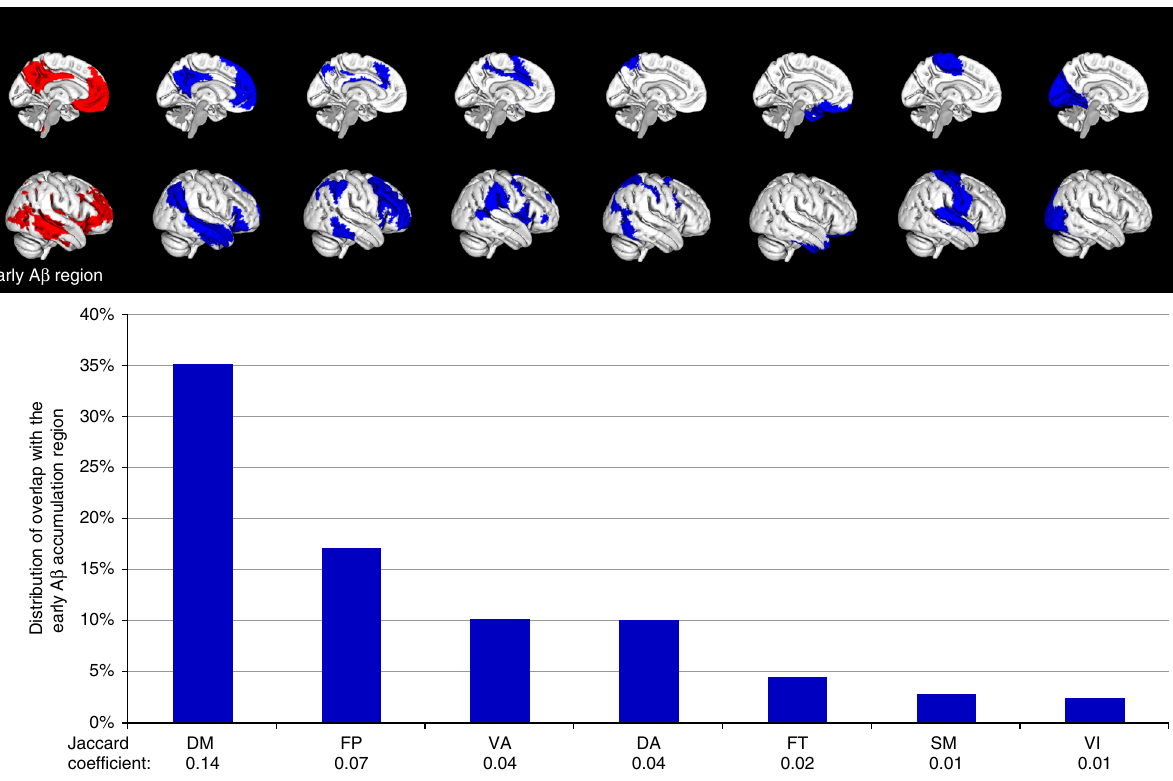
Fig. 2 Distribution of early A β accumulation among functional networks in ADNI. The bars show the distribution of the overlap between the signi fi cant cluster of early A β accumulation (shown in red, see also Fig. 1a) and the functional network ROIs (shown in blue above the bars). The sum of the seven bars is therefore 100%. The pattern of early stage A β fi brils overlapped mostly with the DM followed by the FP network. The Jaccard coef fi cient describes the similarity between the early A β accumulation region and the functional network ROIs. It is calculated as the overlap between the early A β region and the network ROI/(early A β region + network ROI - overlap between early A β region and the network ROI). DA dorsal attention, DM default mode, FP frontoparietal, FT frontotemporal, SM sensory motor, VA ventral attention, VI visual comparisons between early and late accumulators are shown in Fig. 3 and highlight similar late regions (greatest signi fi cant dif- ference in the sensorimotor cortex and parts of the occipital lobe).